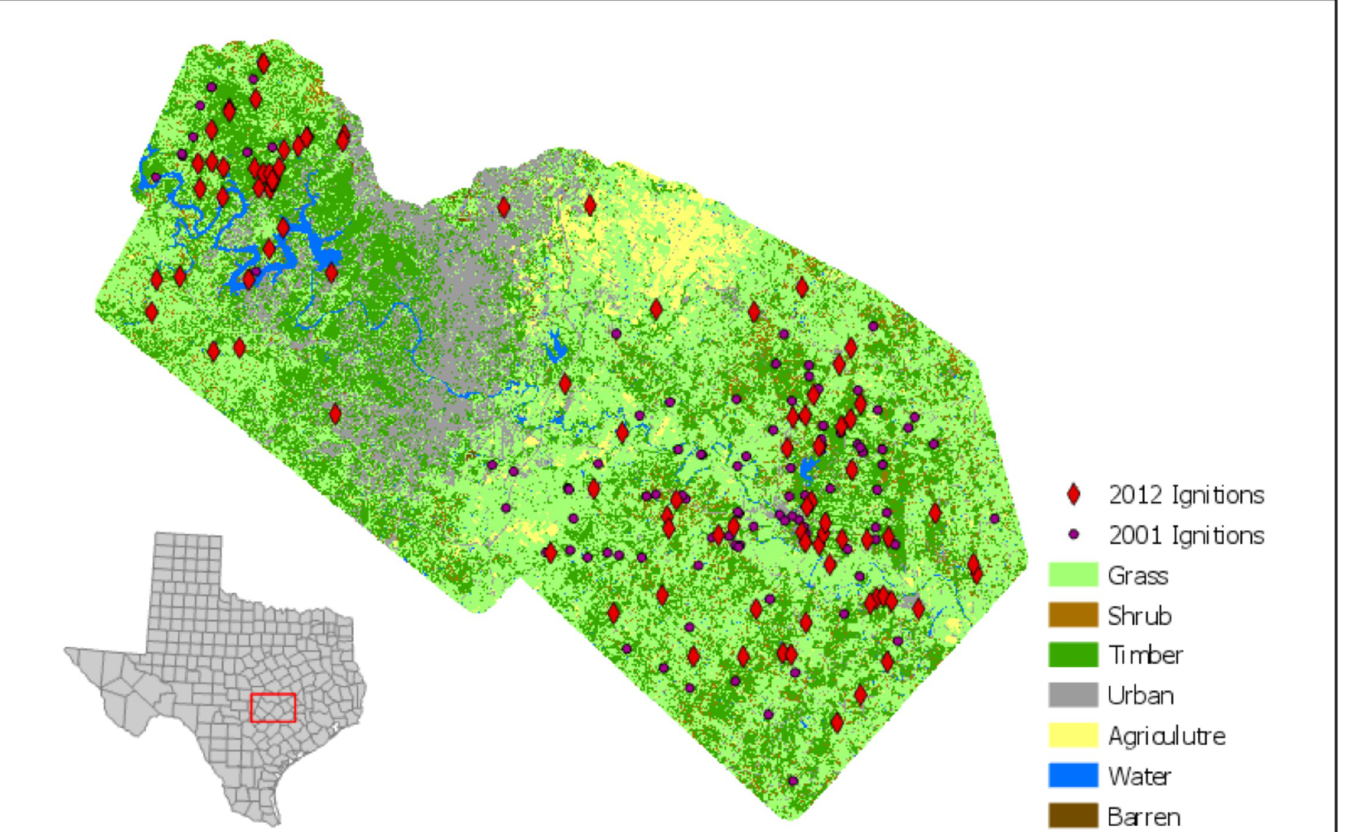
Fig 1. Study area of Bastrop and Travis County. Fuel types are aggregated to more generalized categories.